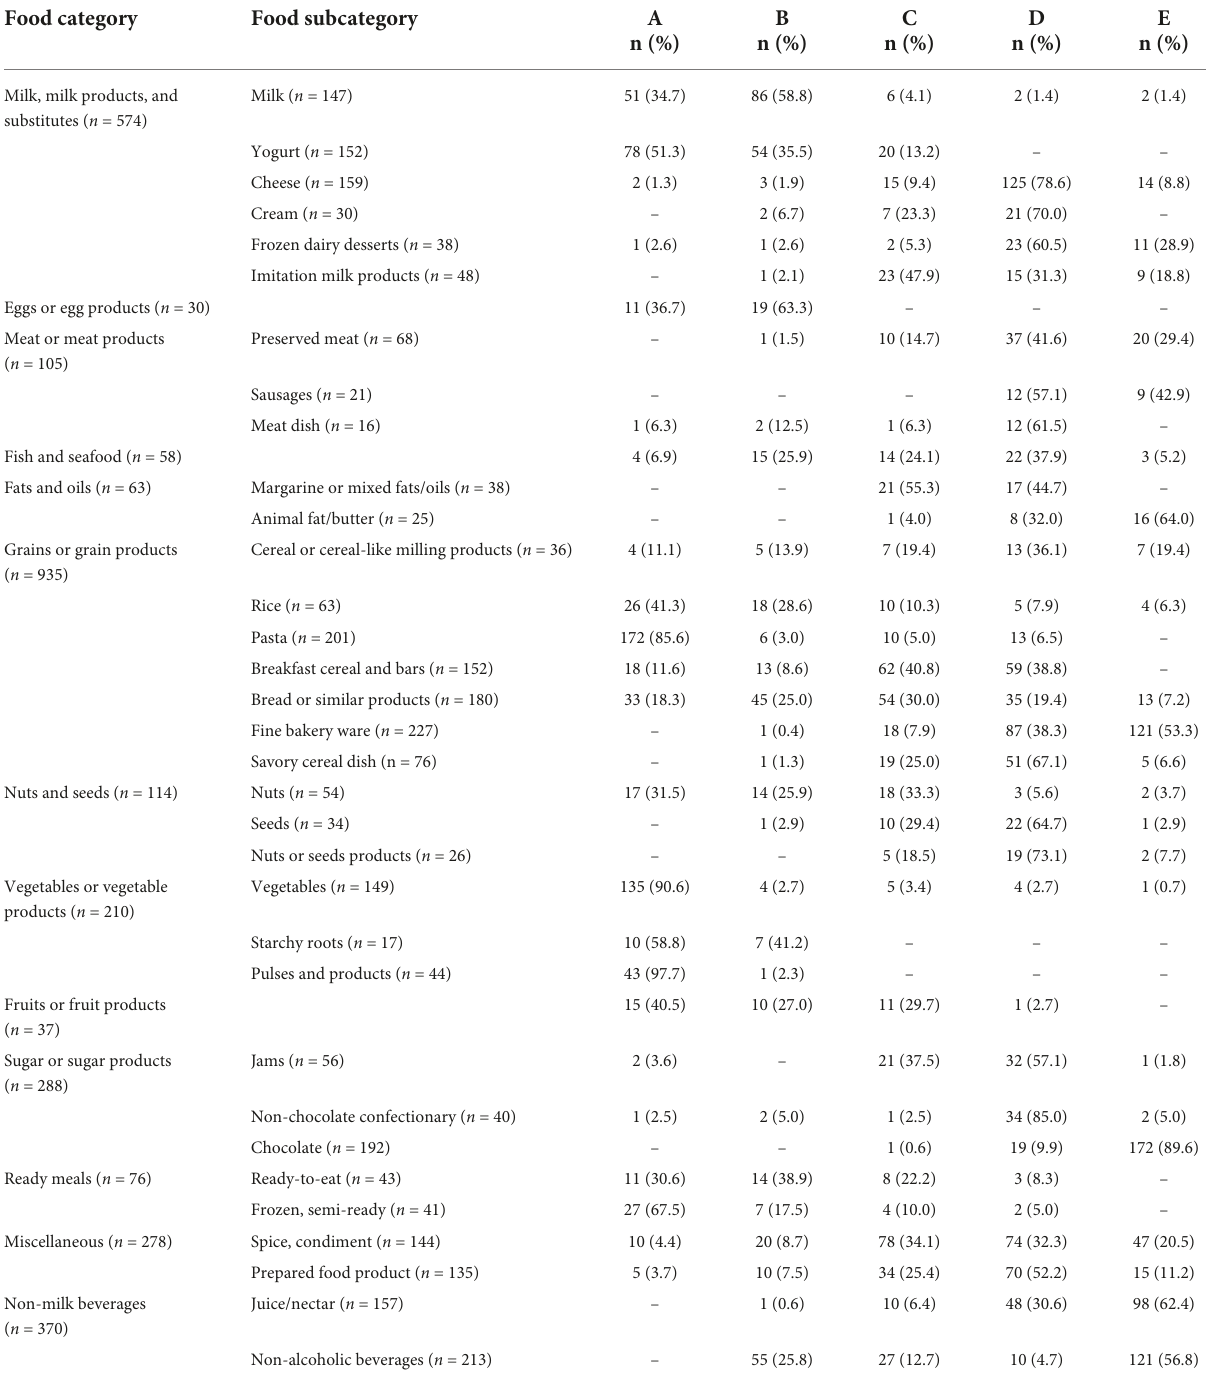
TABLE 2 Nutri-Score distribution in food subcategories ( n = 3,224) of the Hellenic food thesaurus (HelTH) branded food composition databases (BFCD). Food